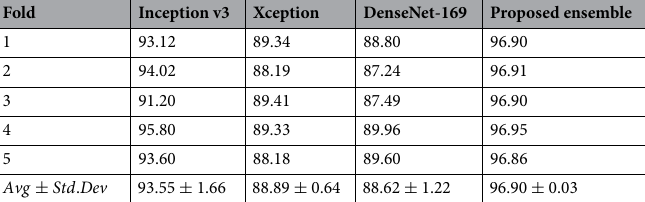
Table 10. Results (accuracies in %) obtained by the proposed ensemble framework and its base classifiers on the Zenodo 5K breast histopathology dataset.